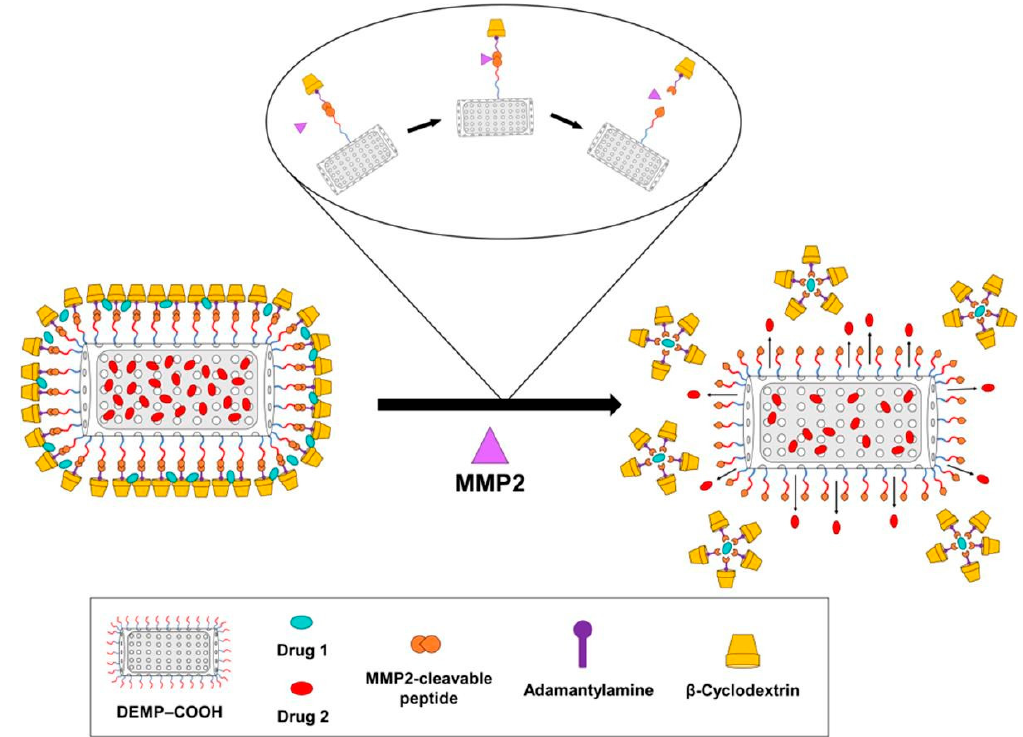
Figure 3. Schematic proof-of-concept of the self-assembled carrier for dual-delivery: the drug release from the core and corona of the functionalized diatom microparticles starts after the cleaving of matrix metalloproteinases-2 (MMP-2) specific peptides in the presence of MMP-2 enzyme. Reproduced from Reference [53], copyright (2020), with permission from Elsevier.